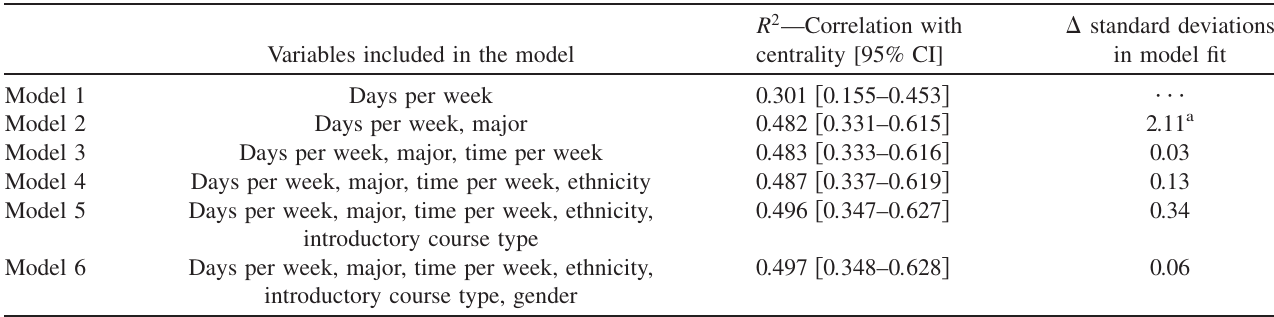
TABLE III. Comparison of hierarchical multiple regression models. (CI is confidence interval.) Variables included in the model